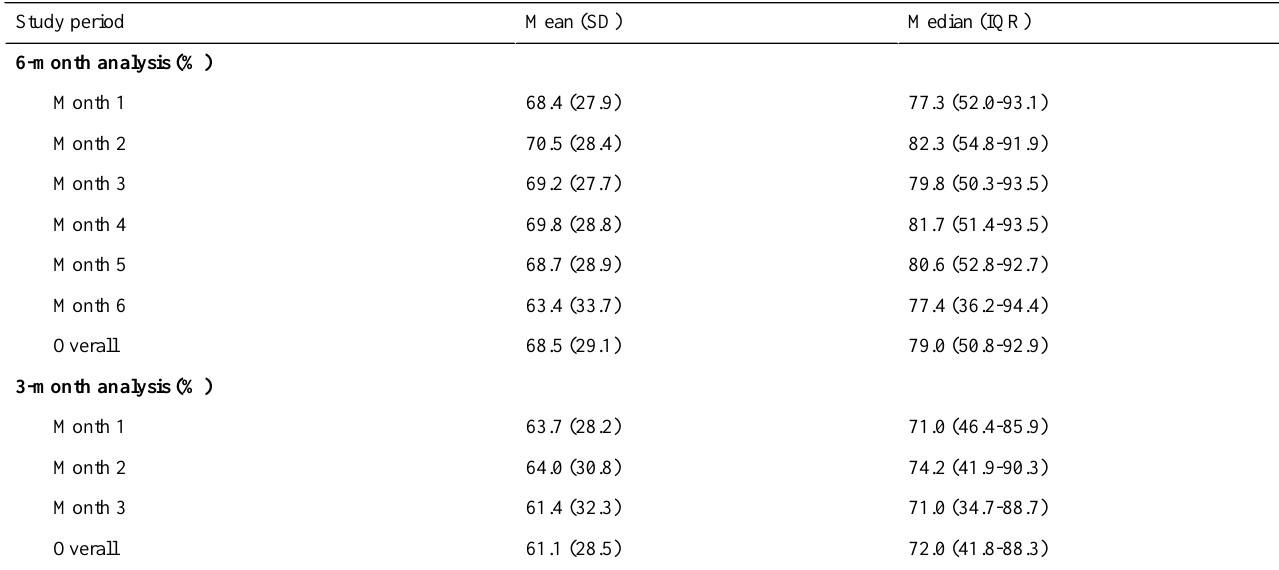
Table 2. Timing adherence across the 6-month and 3-month time